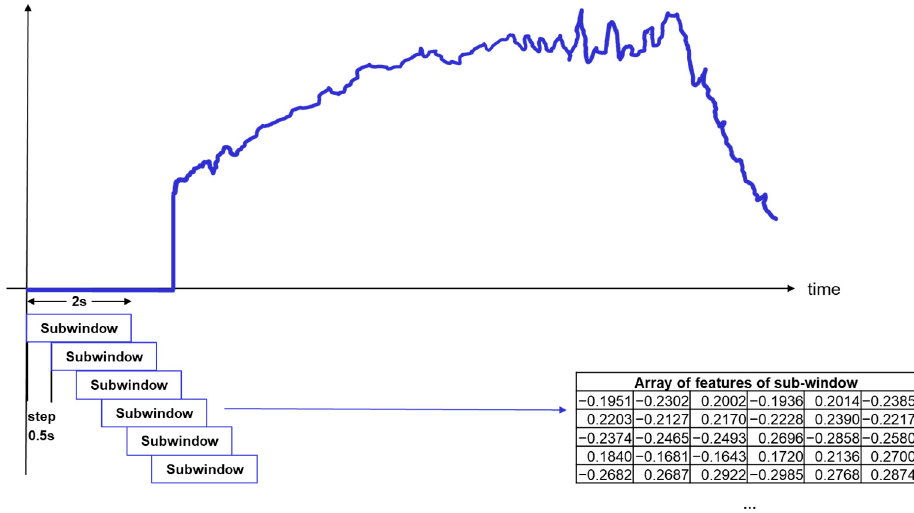
Figure 7. YBT windowing and features computation of sub-windows.